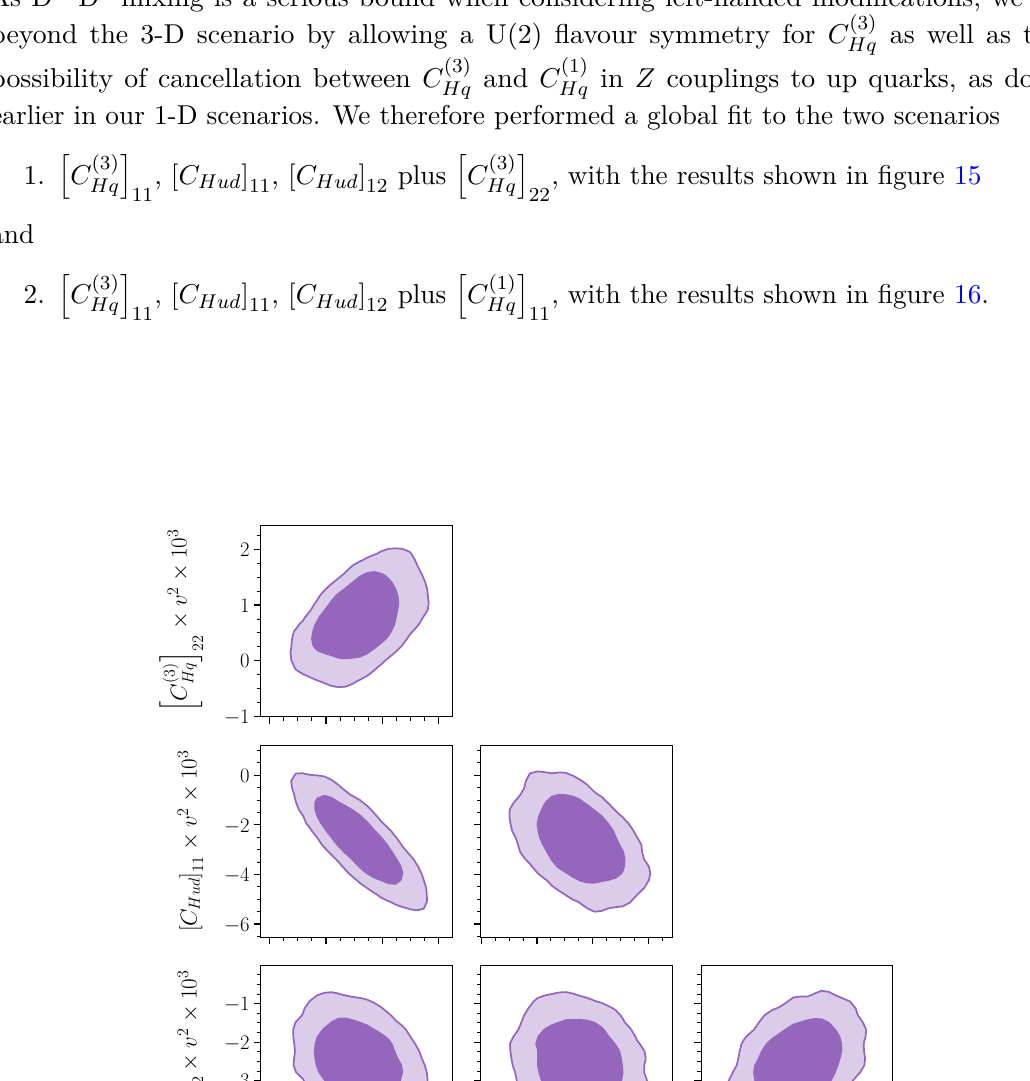
h i h i C (3) C (3) , , [ C Hud ] Hq Hq 11 22